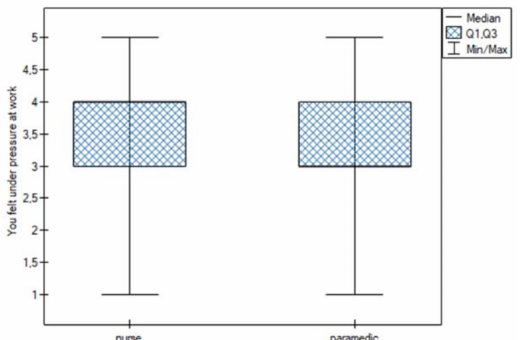
Figure 2. More difficult patients.